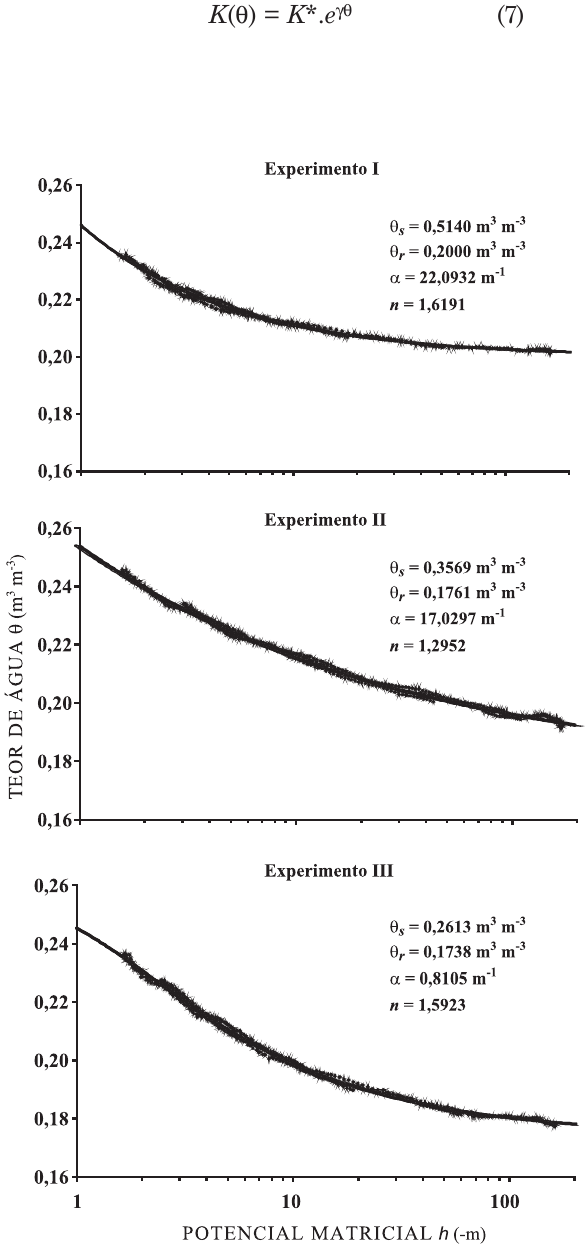
Figura 2. Teor de água em função do potencial matricial (curvas de retenção) para os experimentos I, II e III. Os pontos representam os valores obtidos experimentalmente; a linha é a equação 3